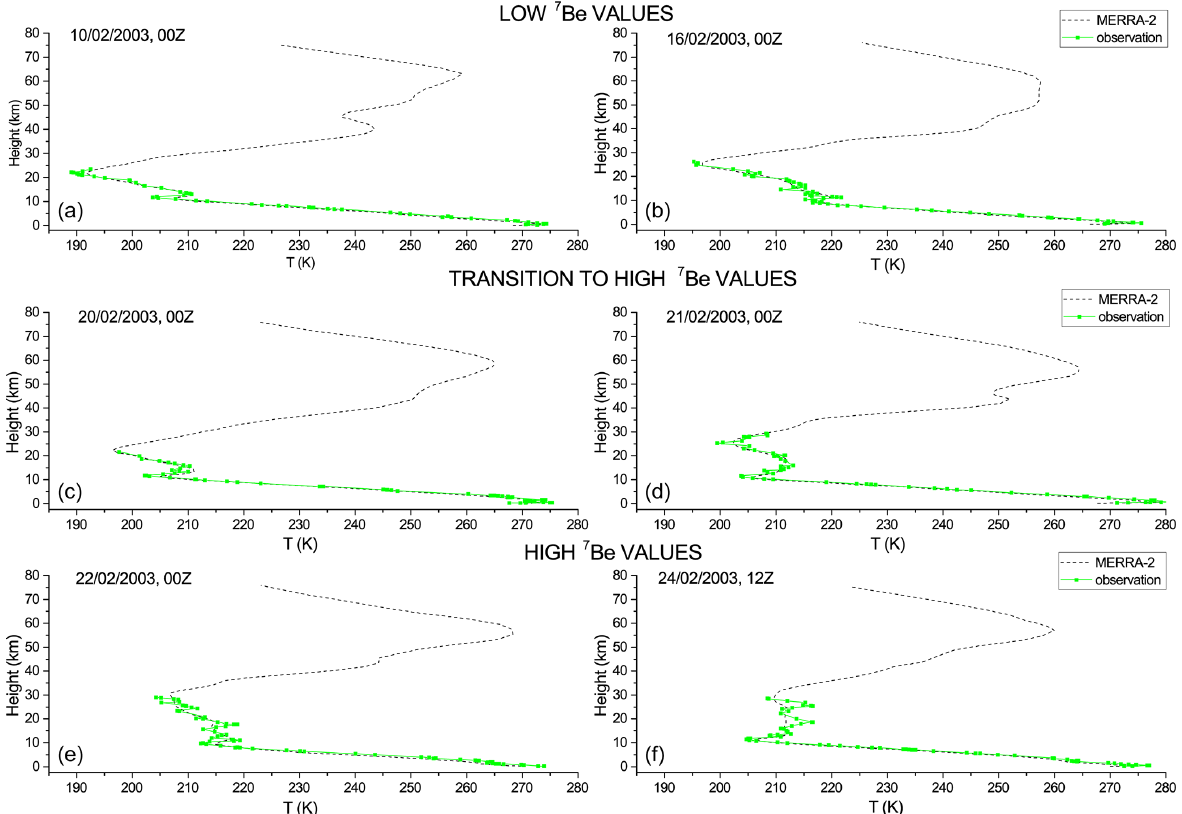
Figure 7. Vertical profiles of air temperature in the MERRA-2 reanalysis (dotted line) and in the soundings at the Sodankylä station in Finland on selected days of low 7 Be values ( a, b : 10 and 16 February 2003, 00:00UTC), transition to high 7 Be values ( c, d : 20 February 2003, 00:00UTC and 21 February 2003, 12:00UTC) and high 7 Be values ( e, f : 22 and 24 February 2003, 00:00UTC) at the six sampling sites in northern